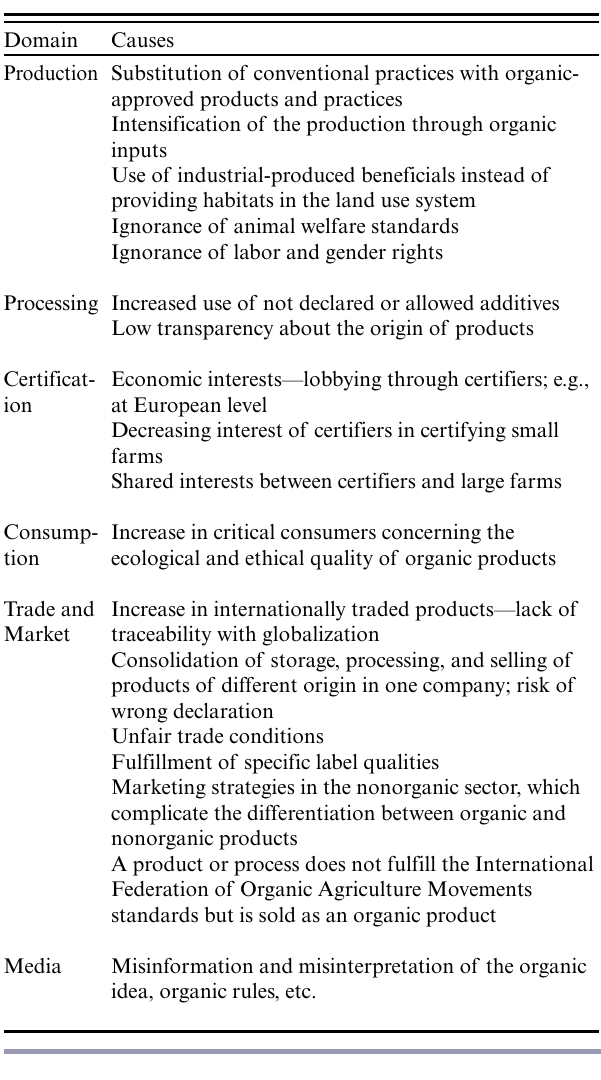
Table 1 . Domain-specific causes driving control and